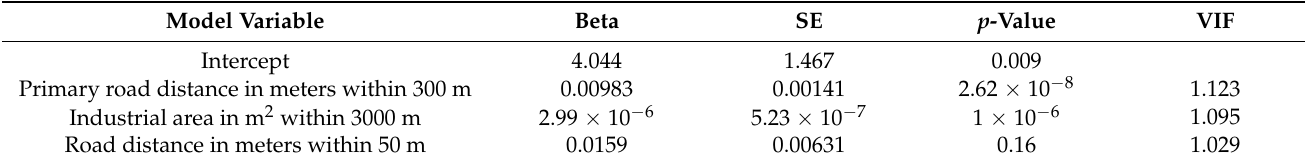
Table 3. Variables and their coefficients (Beta) included in the final LUR model for NO 2 .